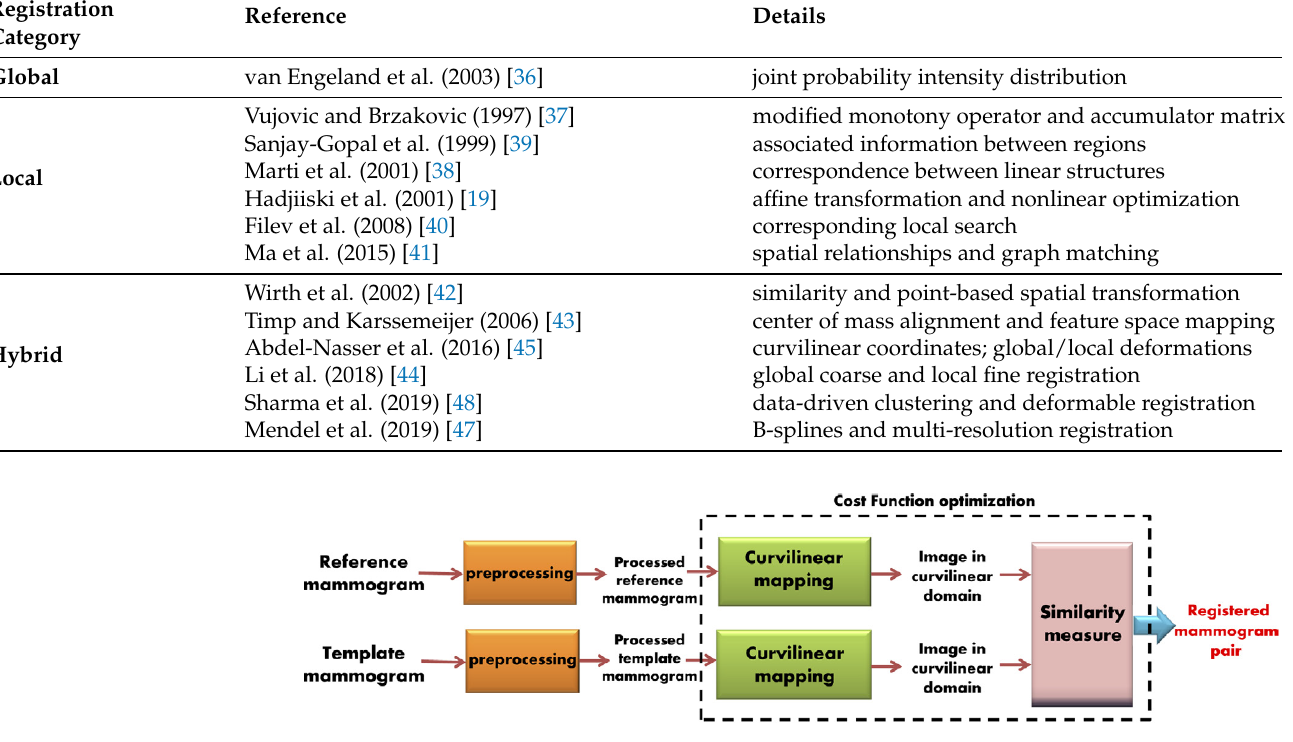
Table 1. The state-of-the-art techniques for the registration of mammograms.